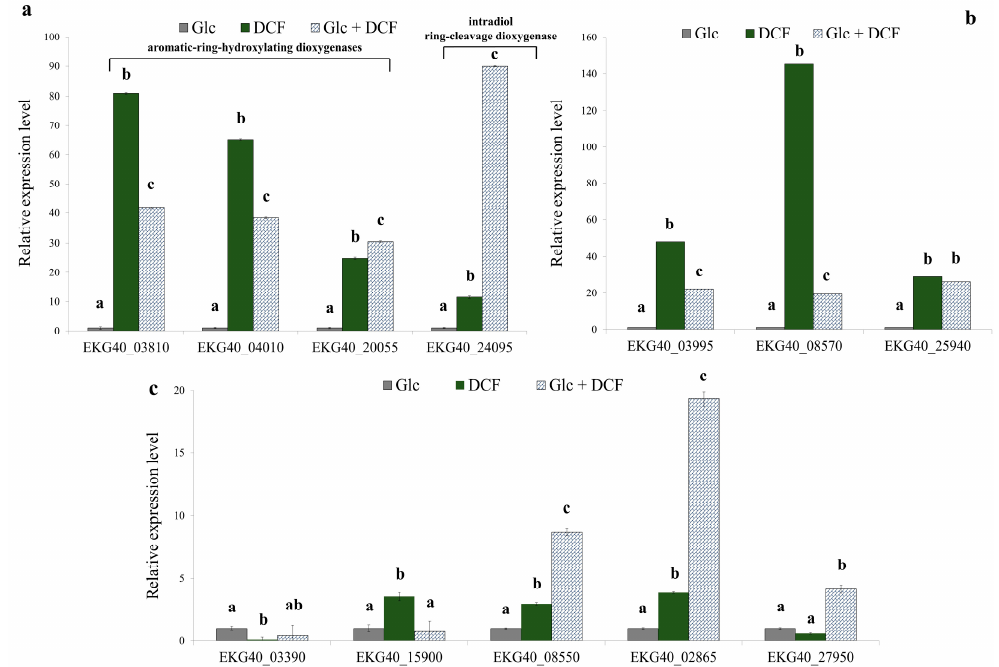
Figure 2. The relative expression level of the selected genes found in the KB4 genome. ( a ) Aromatic- The relative expression level of the selected genes found in the KB4 ring hydroxylating dioxygenases (EKG40_03810, EKG40_04010, EKG40_20055), intradiol ring cleavage-dioxygenase (EKG40_24095); ( b ) catechol 1,2-dioxygenases (EKG40_03995, EKG40_08570 and EKG40_25940); ( c ) deaminases (EKG40_03390 and EKG40_15900), benzoate 1,2-dioxygenase (EKG40_08550), homogentisate 1,2-dioxygenase (EKG40_02865) and cytochrome P-450 (EKG40_27950), which were measured using the RT-qPCR technique with gyrA (EKG40_13720) as the reference gene. The data are presented as the mean ± SD of six replicates; differences in the relative expression level were determined with a one-way ANOVA followed by the Tukey’s test; different letters denote significant differences ( p -value < 0.05) between the treatment.